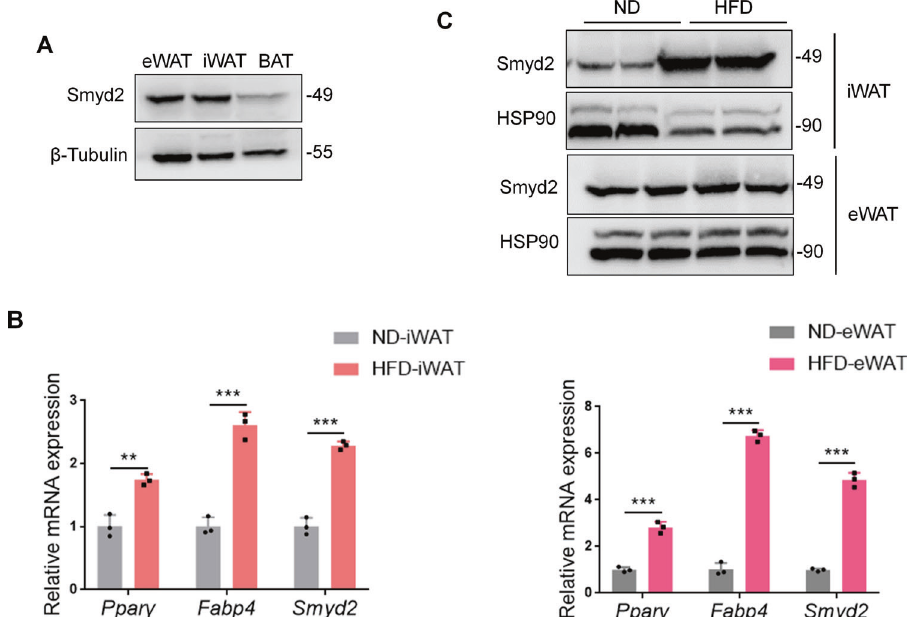
Fig. 1 Smyd2 is abundant in white adipose tissue. A The expression pro fi le of Smyd2 in adipose tissues. The inguinal white adipose tissue (iWAT), epididymal white adipose tissue (eWAT), and brown adipose tissue (BAT) from adult C57BL/6J mice were harvested and examined the protein expression of Smyd2 by western blot assay. n = 3 mice/groups. B The mRNA levels of Smyd2 and the adipocyte marker genes ( Ppar γ , Fabp4 ) were detected in iWAT and eWAT of HFD-induced obese mice and ND-fed control mice. n = 3 mice/groups. C The protein expressions of Smyd2 were detected in iWAT and eWAT of HFD-induced obese mice and ND-fed control mice. n = 3 mice/groups. Data are presented as mean ± SD. ** p < 0.01, *** p <